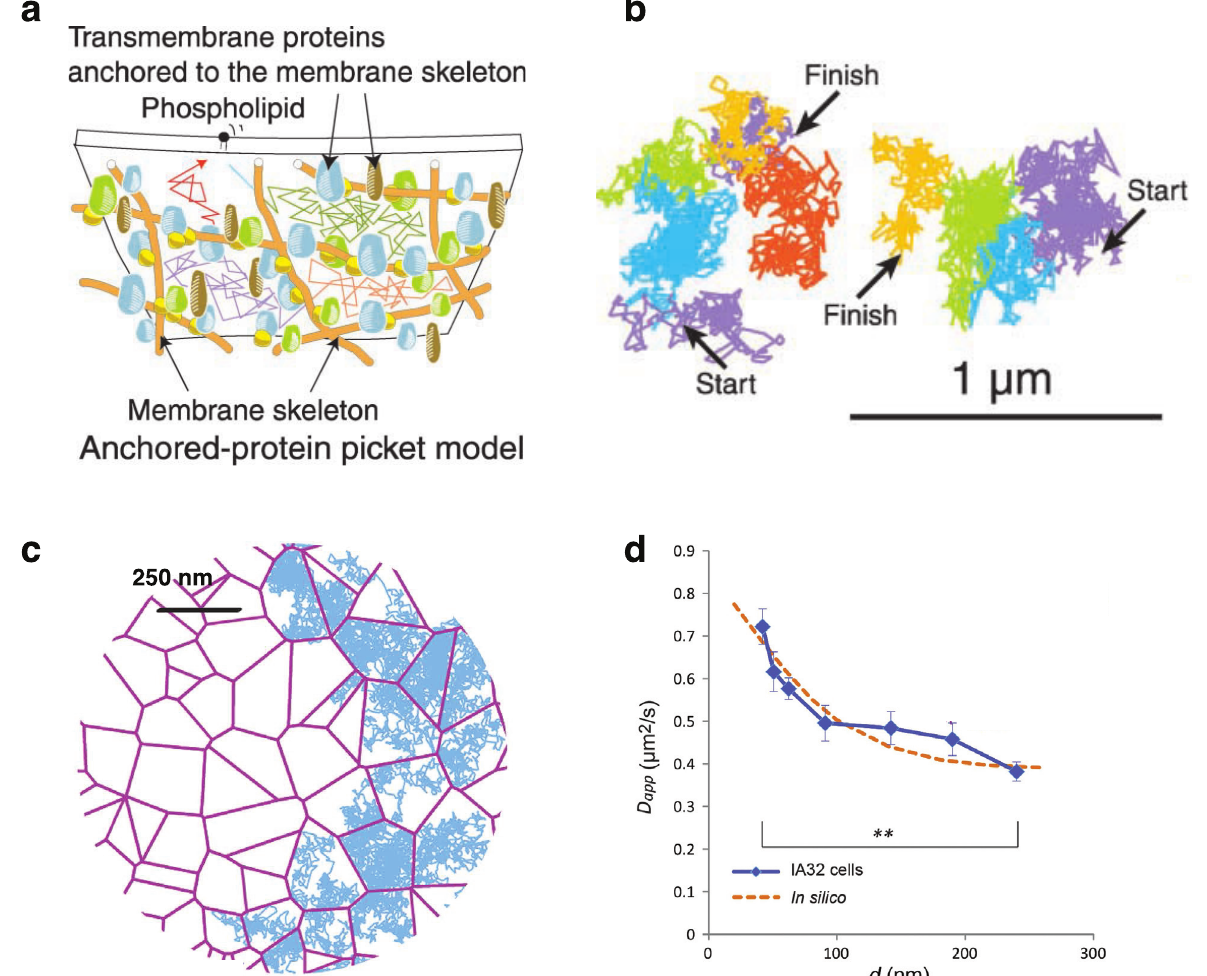
Figure 2. A dynamic view of the membrane. ( a ) Picket-fence model where transmembrane proteins anchored to the actin membrane skeleton meshwork effectively act as rows of pickets and temporarily confine the movement of lipids and proteins through steric hindrance and circumferential slowing (packing or frictional) effects. ( b ) Two representative trajectories of 1,2-dioleoyl- sn -glycero-3-phosphoethanolamine (DOPE) lipids on a living cell membrane recorded at a time resolution of 25 μs (40,500 frames/s) for a period of 56 ms (2,250 frames) where plausible compartments are shown in different colors. ( c ) Schematic Voronoi lattices (purple) representative of actin-based compartment sizes together with simulated diffusion trajectories (cyan). Scale bar: 250 nm. ( d ) Dependency of the apparent diffusion coefficient of di-palmitoyl phosphoethanolamine (DPPE) lipids on the area of observation (blue line). Images reproduced with permission from 69 ( a , b ) and 135 ( c , d